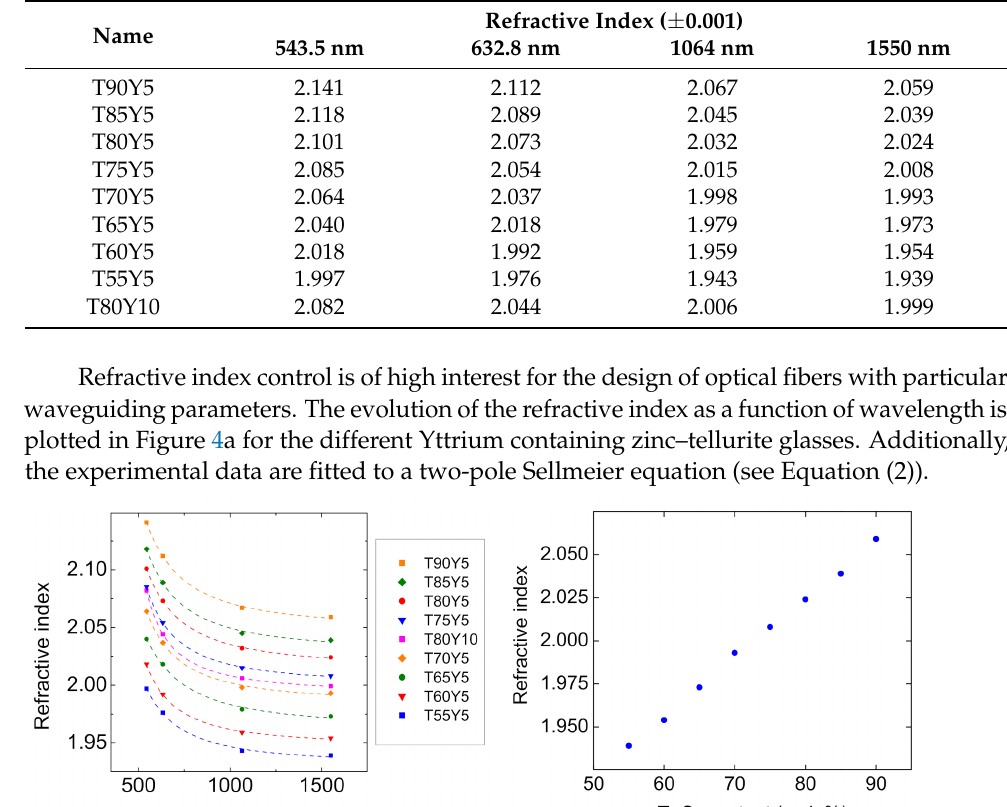
Table 2. Refractive indices of the glasses considered in this work measured at 543.3, 632.8, 1064 and 1550 nm.